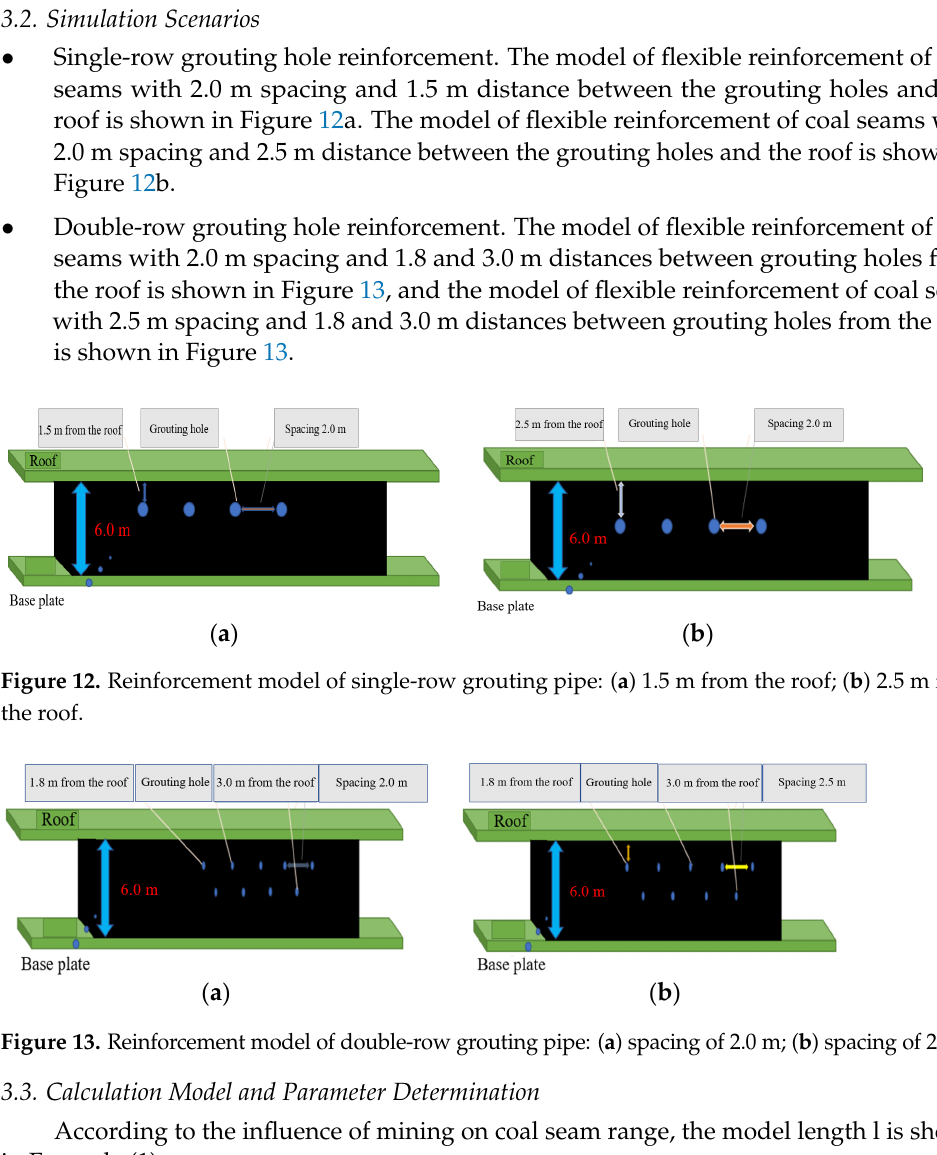
Figure 13. Reinforcement model of double-row grouting pipe: ( a ) spacing of 2.0 m; ( b ) spacing of 2.5 m.